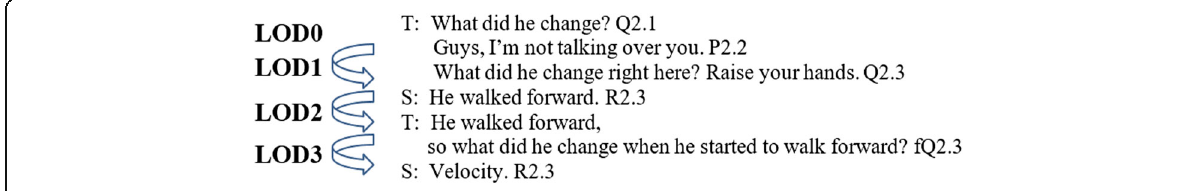
Fig. 3 Length of dialog that counts the number of turn-changes between a teacher and students in the